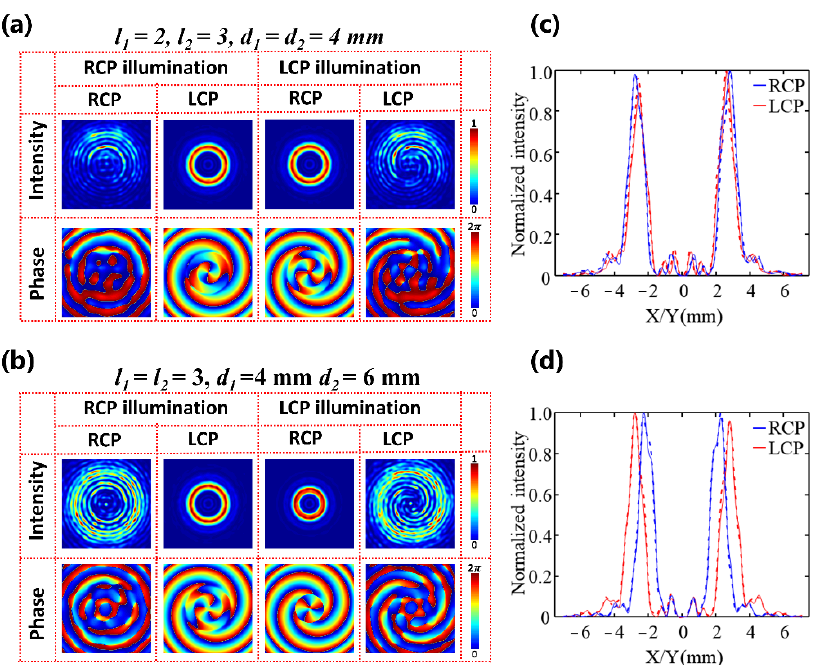
Figure 8. ( a , b ) The normalized intensity profile and phase distribution for devices I and II at focus point when only the RCP or LCP beam is incident. ( c , d ) Corresponding normalized cross-section of the annular intensity distribution for RCP (blue) and LCP (red) polarization along x-direction (solid line) and y-direction (dashed line).